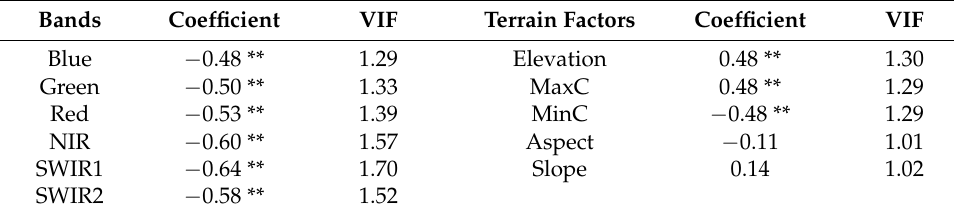
Table 5. The linkage between variables and soil organic carbon